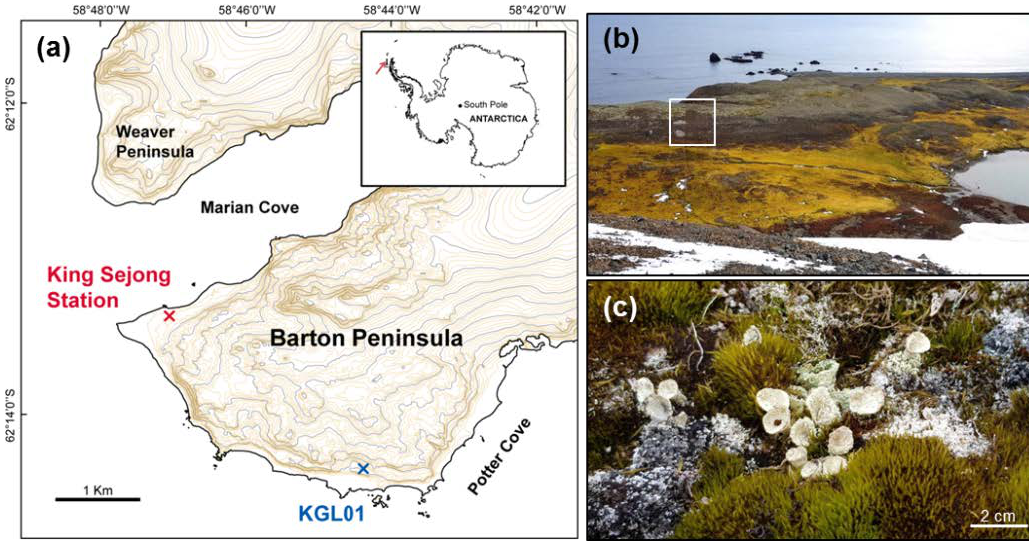
Figure 1. Location and landscape of the study site (KGL01: 62°14 ′ 24 ″ S, 58°44 ′ 36 ″ W), and an image of C. borealis at the field. ( a ) KGL01 on the map, placed near Potter Cove in Barton Peninsula. ( b ) This site has well-distinguished vegetation that consists of mosses and lichens. The area spanning the brown and grey parts was composed of lichens, and our observation was performed at the area indicated by the white box. ( c ) Several thalli of C. borealis accompanied by the moss Chorisdontium aciphyllum are shown.